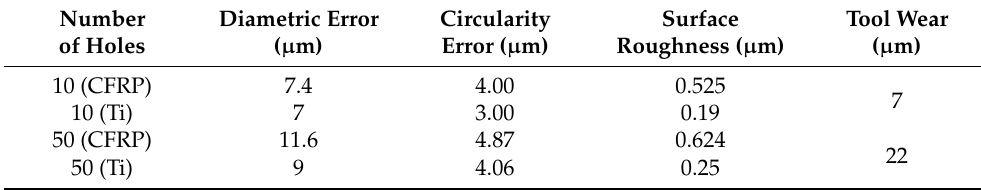
Table 12. Results of experiments for assessing hole accuracy and surface